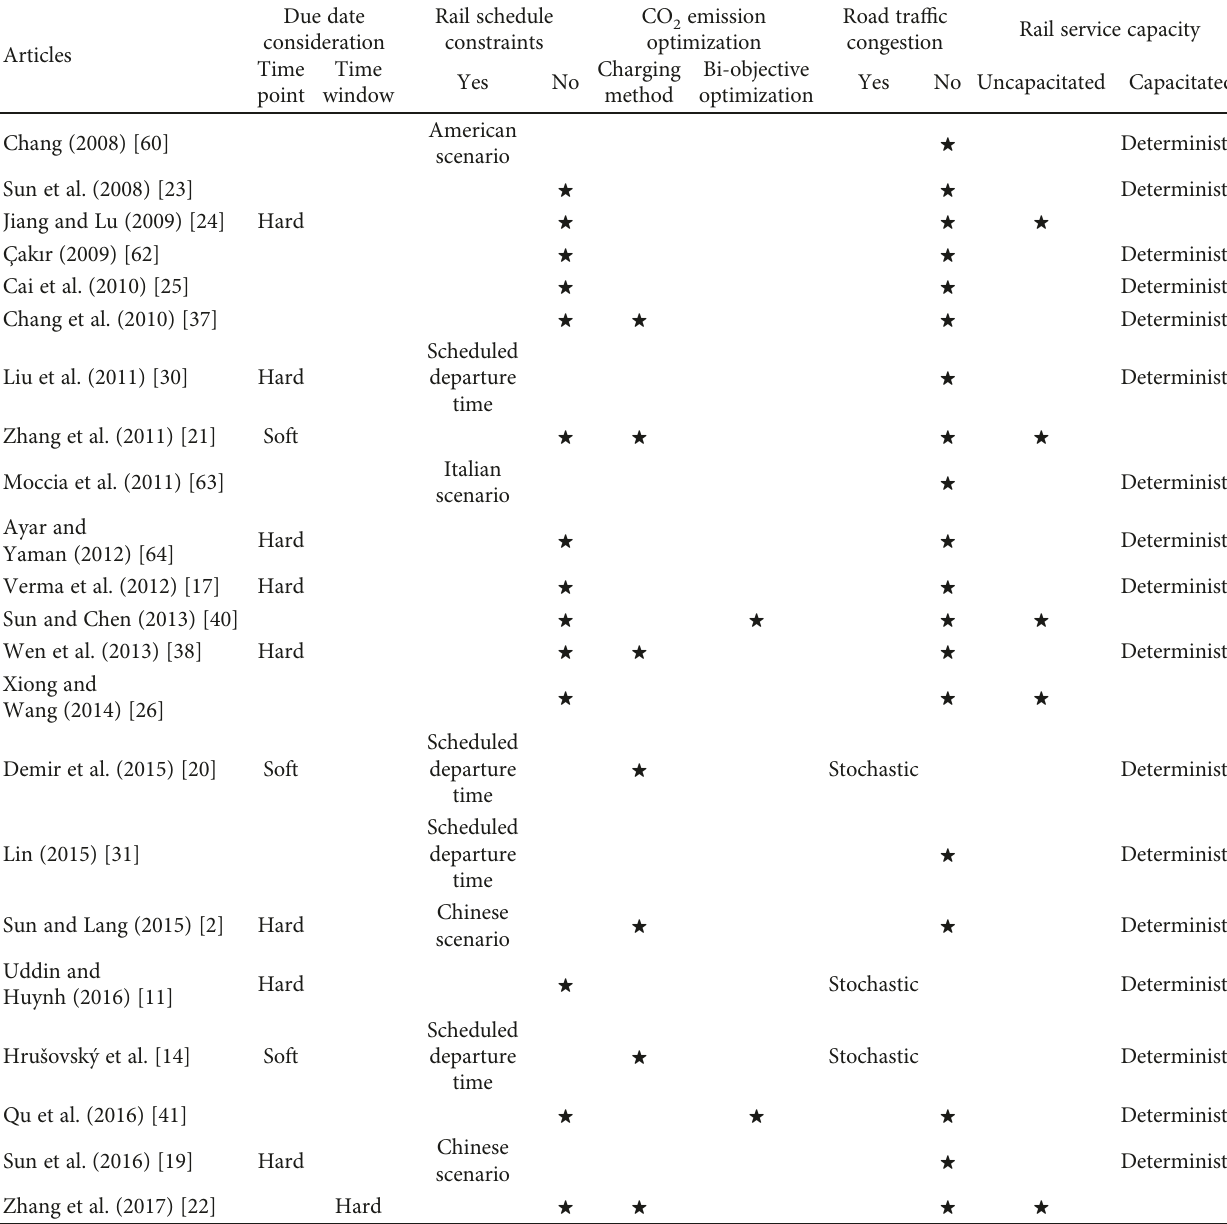
Table 1: Literature review of the articles in the multimodal routing